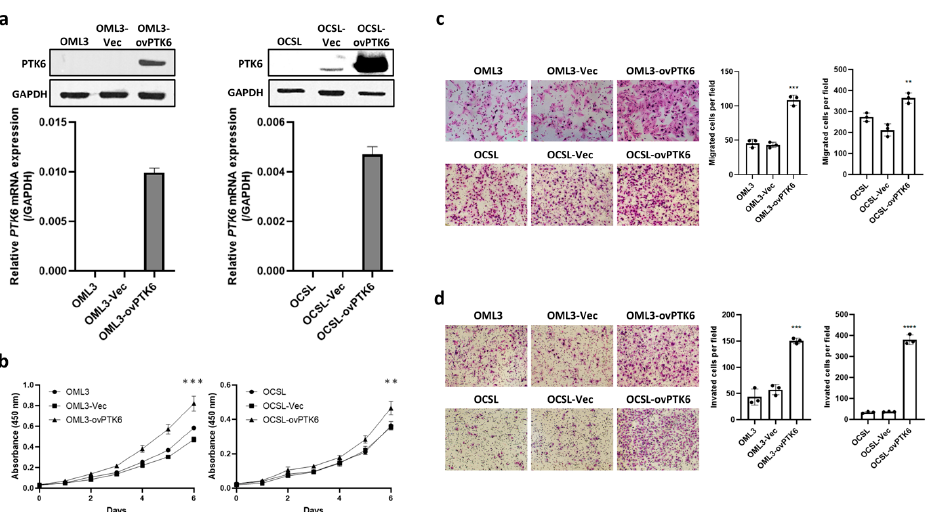
Figure 4. Upregulation of PTK6 facilitated OSCC cell migration and invasion. ( a ) PTK6 overexpres- sion was induced in OML3 and OCSL cell lines by transfecting a PTK6 overexpression plasmid. The mRNA and protein expression were examined through real-time PCR and Western blotting in PTK6 overexpression cells. ( b ) Cell viabilities of control and PTK6 overexpression cells were examined using a WST-1 assay. Absorbance was measured at 450 nm at seven time points (0, 24, 48, 72, 96, 120, and 144 h) to calculate the proliferation rate. ( c ) The migration abilities of control and PTK6 overexpression cells were examined using a transwell assay. Migrated cells were quantified using ImageJ. ( d ) The invasive abilities of control and PTK6 overexpression cells were measured using a transwell Matrigel assay. Invasive cells were quantified using ImageJ. ns means not significant. ** p < 0.01; *** p < 0.005; **** p <